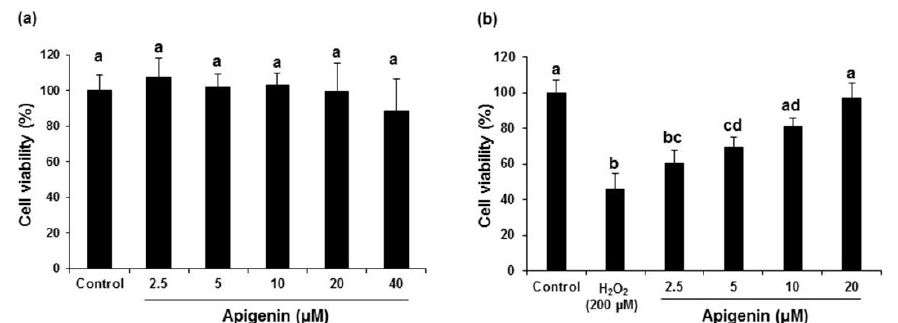
Figure 2. Effects of apigenin on cell viability in GC-2spd sperm cells. Cell viability was evaluated using the MTT assay. ( a ) The effect of apigenin (2.5, 5, 10, 20 and 40 µ M) on the viability of GC-2spd cells. ( b ) The effect of apigenin (2.5, 5, 10 and 20 µ M) in GC-2spd cells exposed to 200 µ M hydrogen peroxide. Data are expressed as the mean ± standard deviation. The groups of control, H 2 O 2 , and different concentrations of apigenin were compared with each other, and letters on the top of the columns that do not share the same letters are statistically significant among the groups ( p < 0.05) by one-way